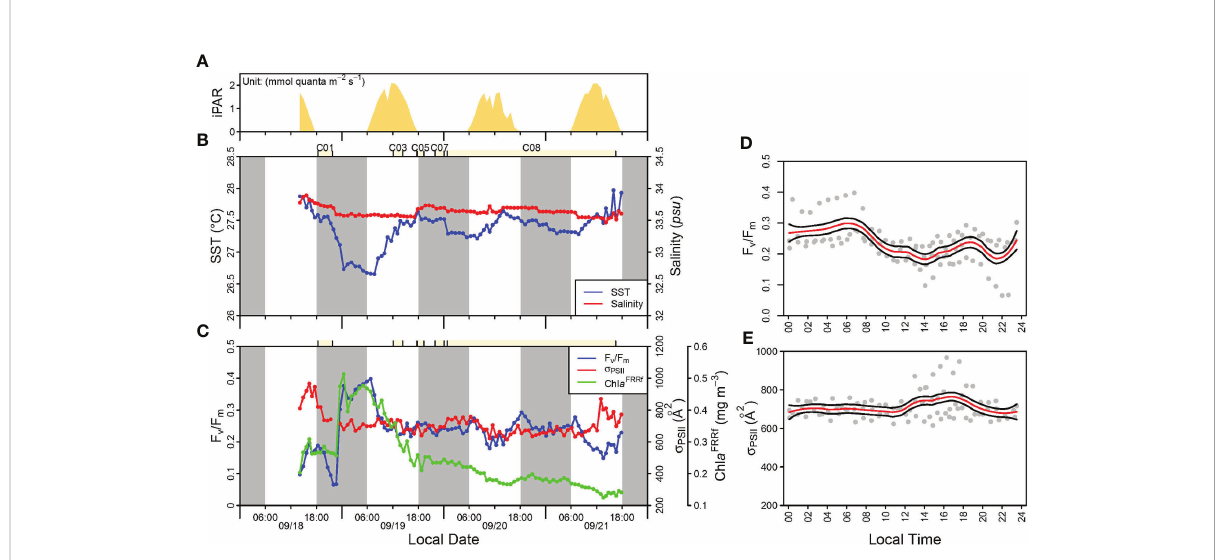
FIGURE 5 The incident irradiance (A) ; environment conditions including SST and salinity (B) ; F v /F m , s PSII , and Chl a FRRf (C) ; diel pattern of F v /F m (D) ; and diel pattern of s PSII (E) for the continental shelf of the northern SCS (Section S1). Light yellow, white, and gray-shaded area indicate the HPLC sample station and local daytime and nighttime, respectively. The red lines in panels (D) and (E) are smoothed using the loess method (span = 0.3), while the black lines represent the regression values ±